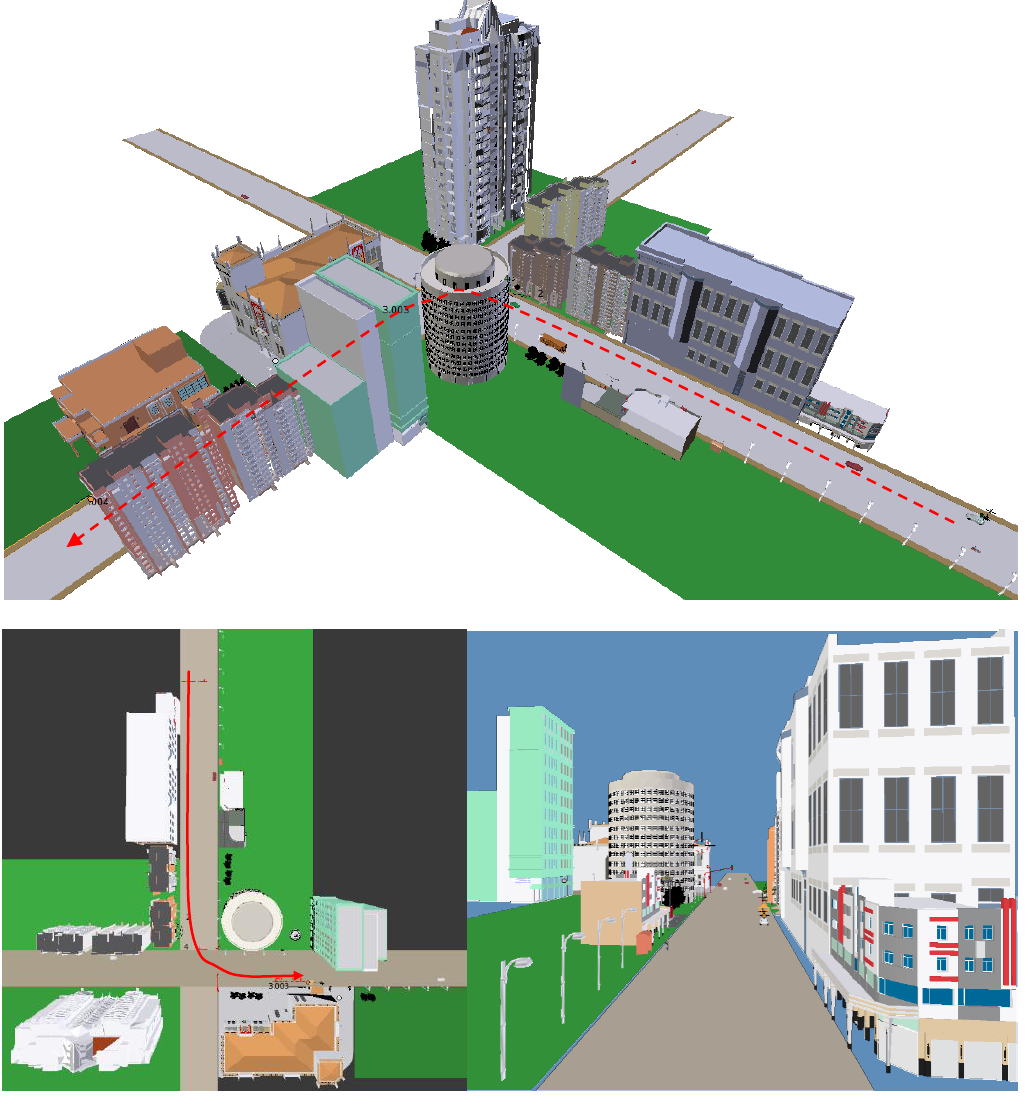
Figure 10. Virtual reality simulation urban model.